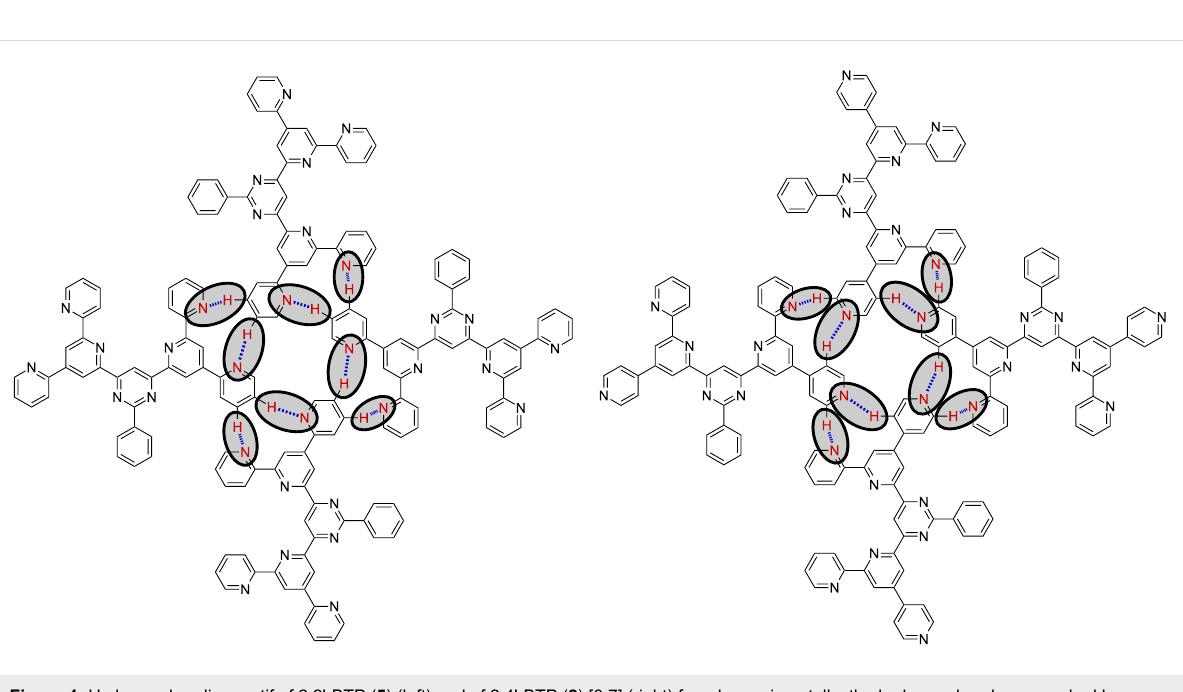
Figure 4: Hydrogen bonding motif of 2,2'-BTP ( 5 ) (left) and of 2,4'-BTP ( 2 ) [6,7] (right) found experimentally; the hydrogen bonds are marked by